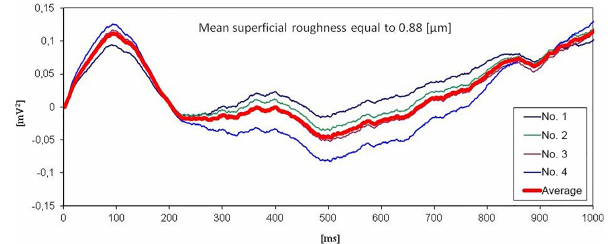
Figure 7. Cross-correlation repeatability test.